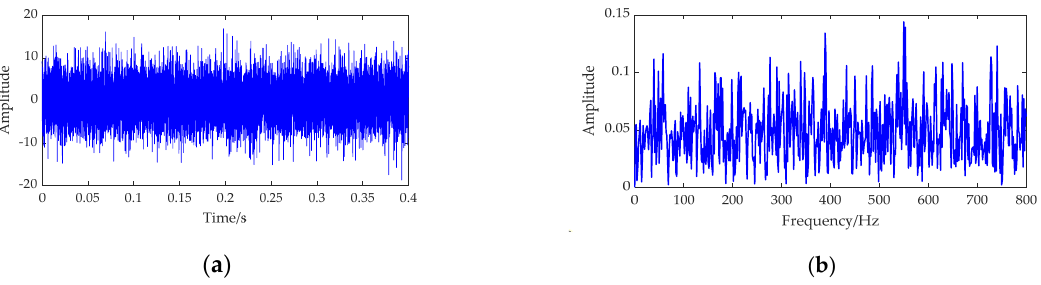
Figure 13. Outer ring fault signal. ( a ) Time-domain waveform. ( b ) Envelope spectrum.